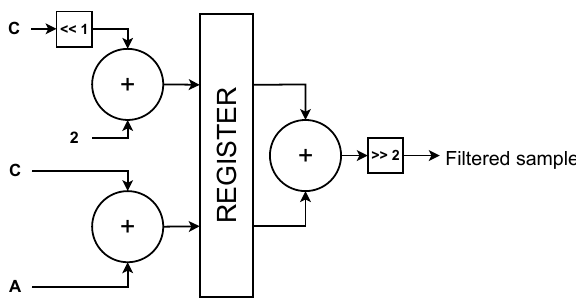
Figure 6. Implementation of a TREE-TAP FILTER.